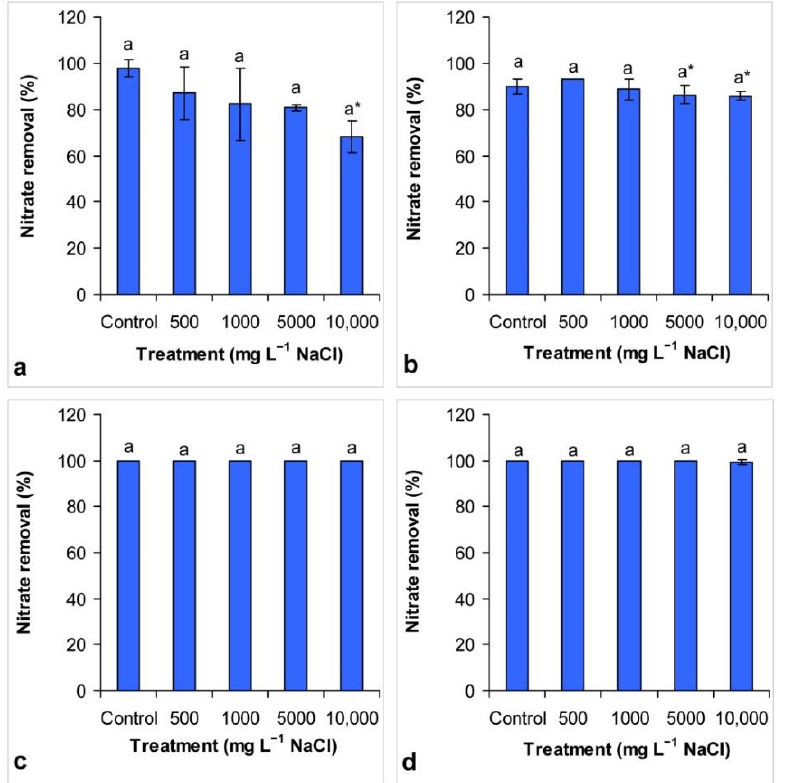
Figure 2. Nitrate removal (%) of control and NaCl-treated Coelastrum morus cultures in: ( a ) HC-LR; ( b ) HC-HR; ( c ) LC-HR and ( d ) LC-LR media. HC: higher content; LC: lower content; HR: higher ratio; LR: lower ratio. Mean values ( n = 3) and standard deviations are plotted. Significant differences ( p < 0.05) are indicated by different lowercase letters. Lowercase letters with asterisks show partial significant difference when it cannot be marked by a different letter.